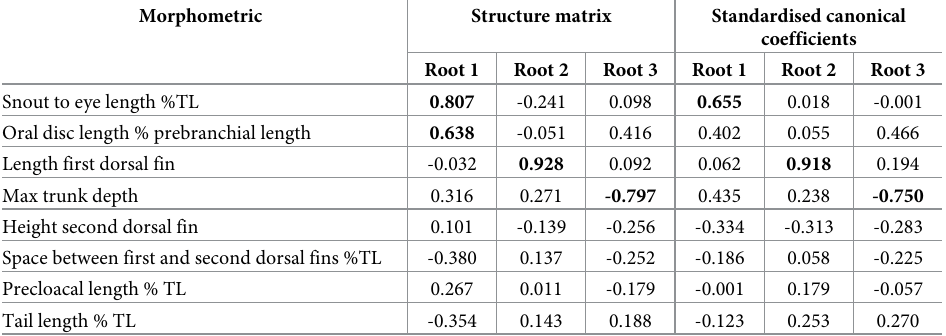
Table 2. Structure matrix and standardised canonical coefficients resulting from the discriminant function analy- sis on immature and mature G . australis and G . macrostoma .